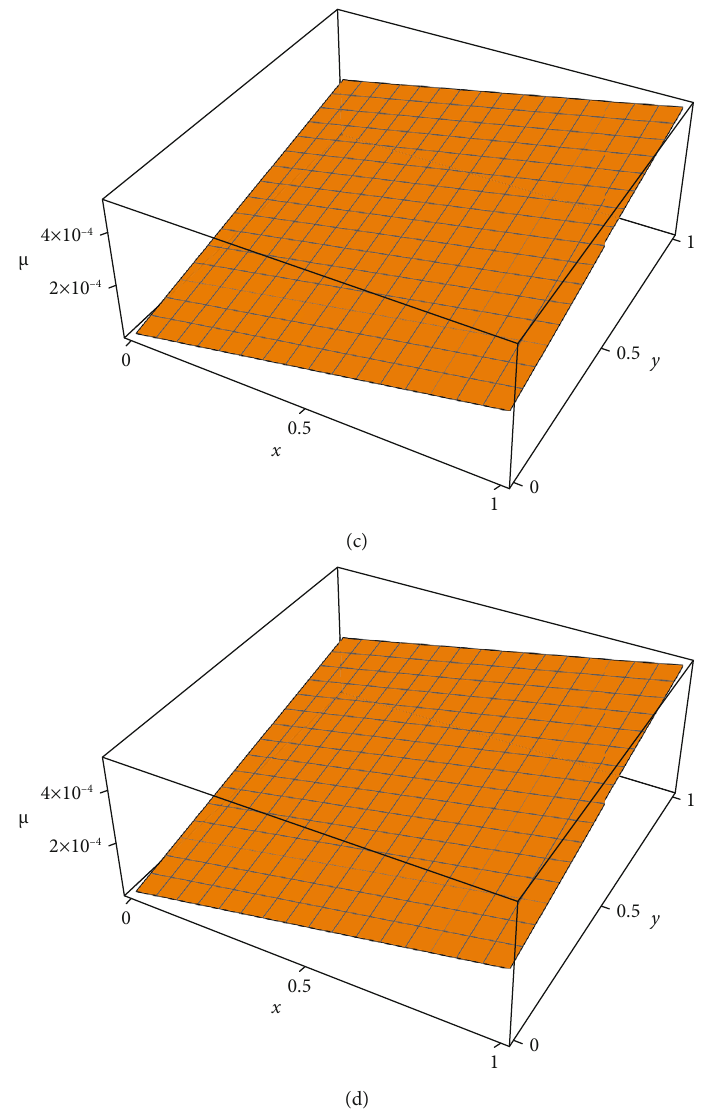
for μ = 0 : 60 . (b) NTDM CF